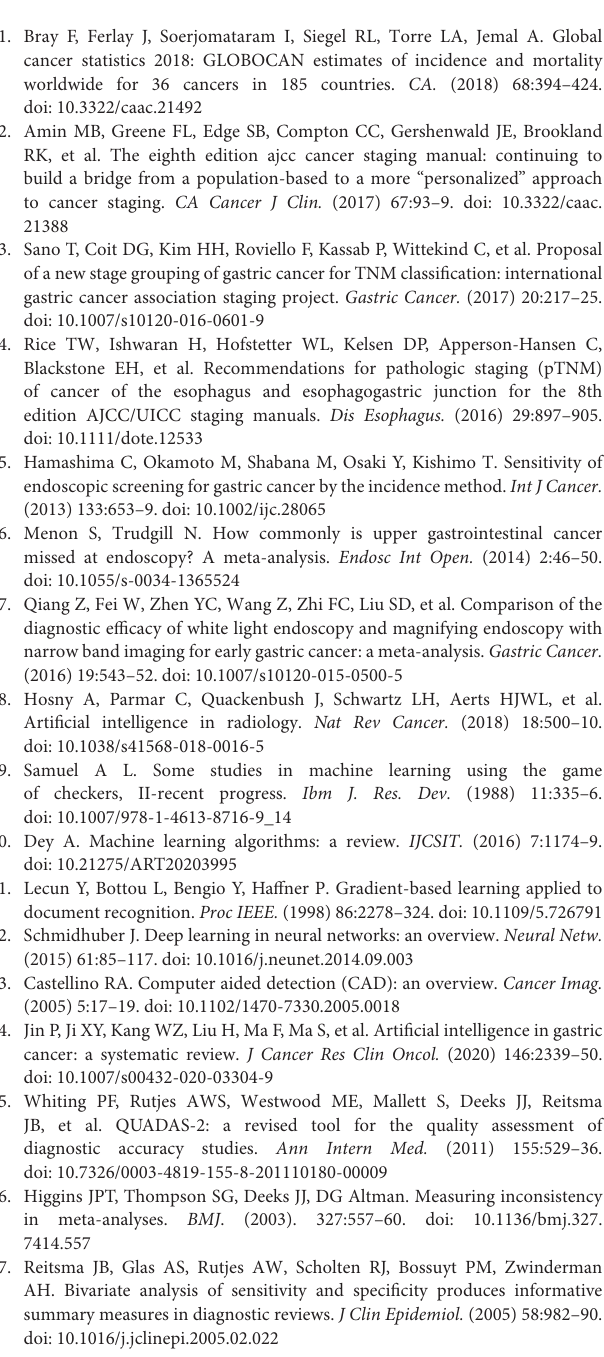
Supplementary Figure 1 | Literature screening flow according to PRISMA.